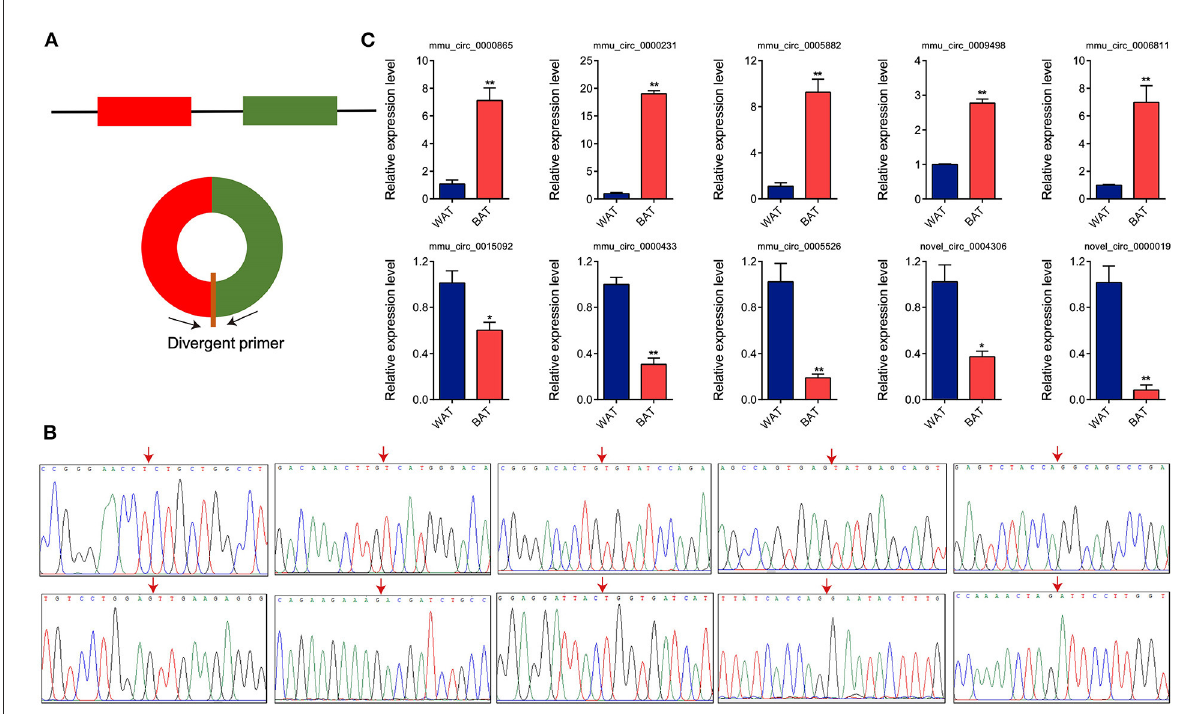
FIGURE4 Validation of differentially expressed circular RNAs (circRNAs) through Sanger sequencing and RT-qPCR. (A) Schematic illustration of the divergent primer design. (B) Sanger sequencing of the polymerase chain reaction products. Arrow represents back-spliced junction. (C) Relative expression levels of 10 randomly selected circRNAs. Values in (C) are means ± SEM ( n = 3). * P < 0.05, ** P <